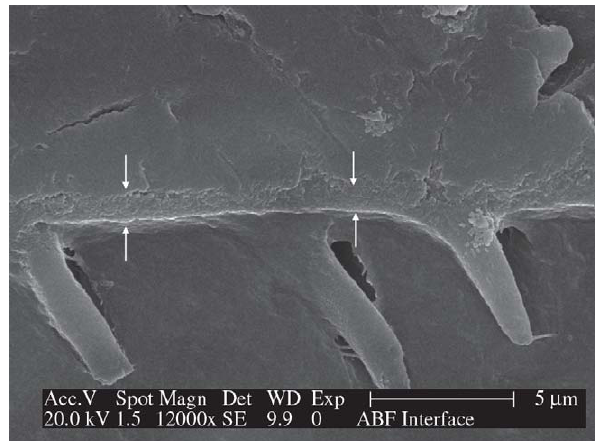
Figure 4. SEM micrograph of resin-dentin interface created by Adper Prompt. A non-uniform hybrid layer (arrows) and the poorly formed resin tag can be observed. Areas of discontinuity can also be noted (circle).